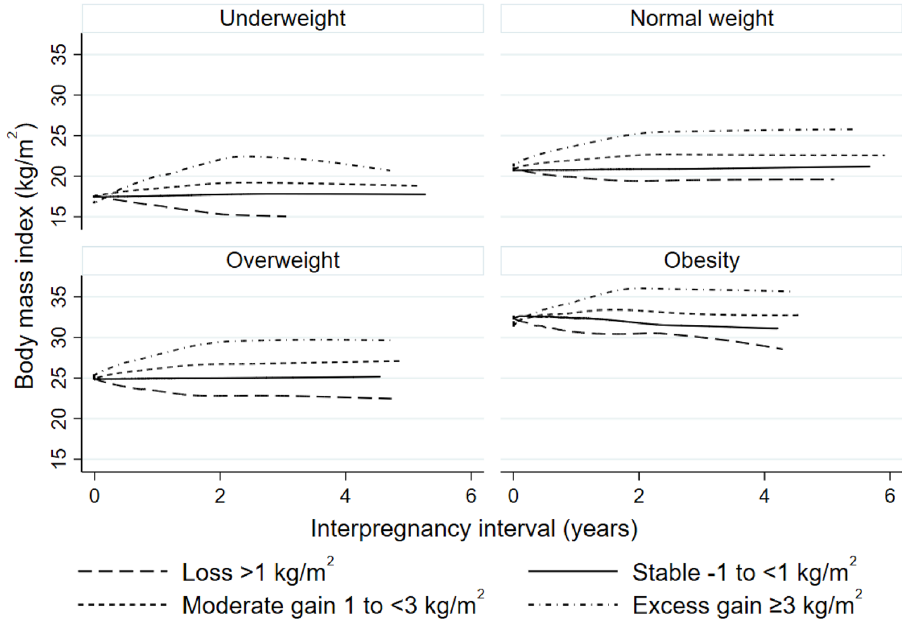
Figure 1. Cross-sectional trends of BMI change over interpregnancy interval. BMI categories of women were measured at 12-week gestation in the first pregnancy (n = 6264). BMI, body mass